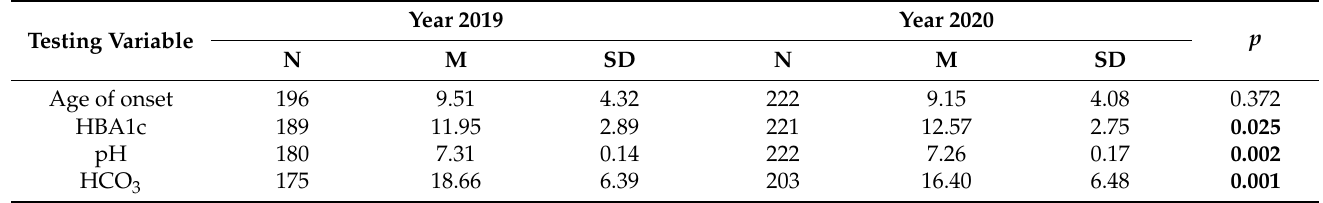
Table 2. Analysis of differences using Student’s t-test for data of independent measurements from 2019 and 2020 for selected indicators in